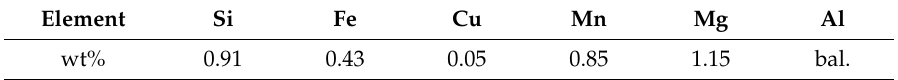
Table 1. Chemical composition of the